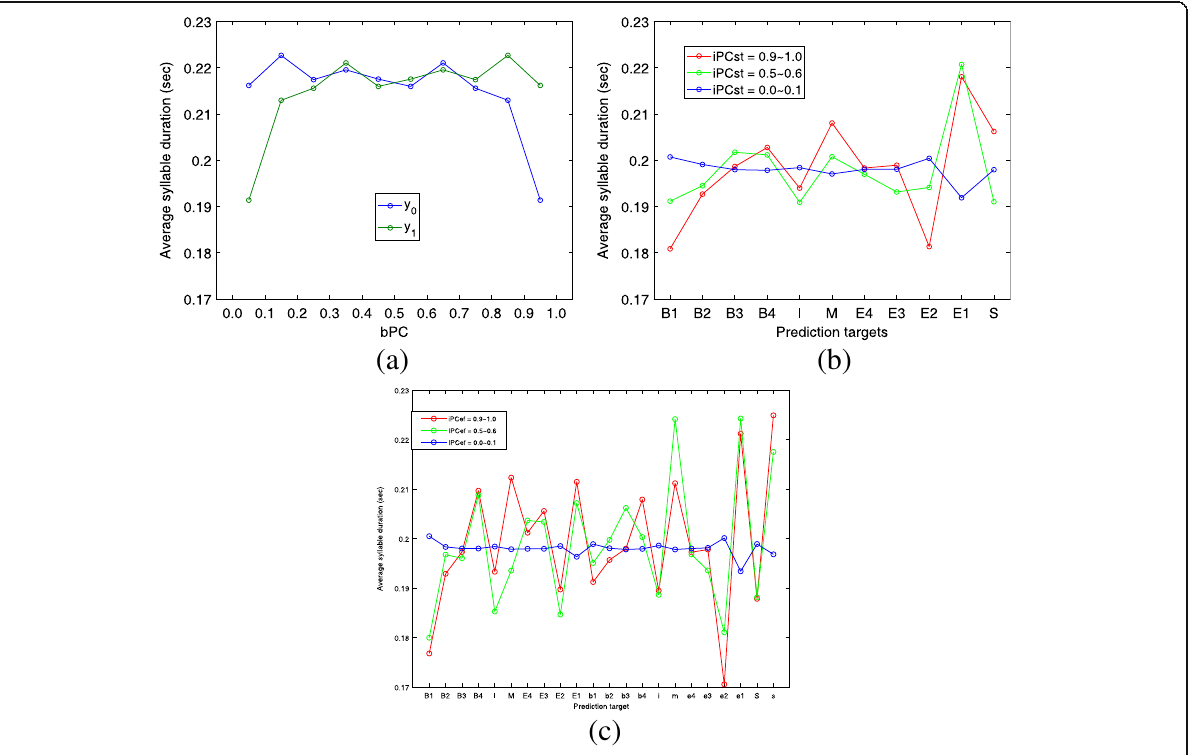
Fig. 6 Average syllable durations corresponding to the prediction targets for a bPC, b iPCst, and c iPCef in different levels of PC